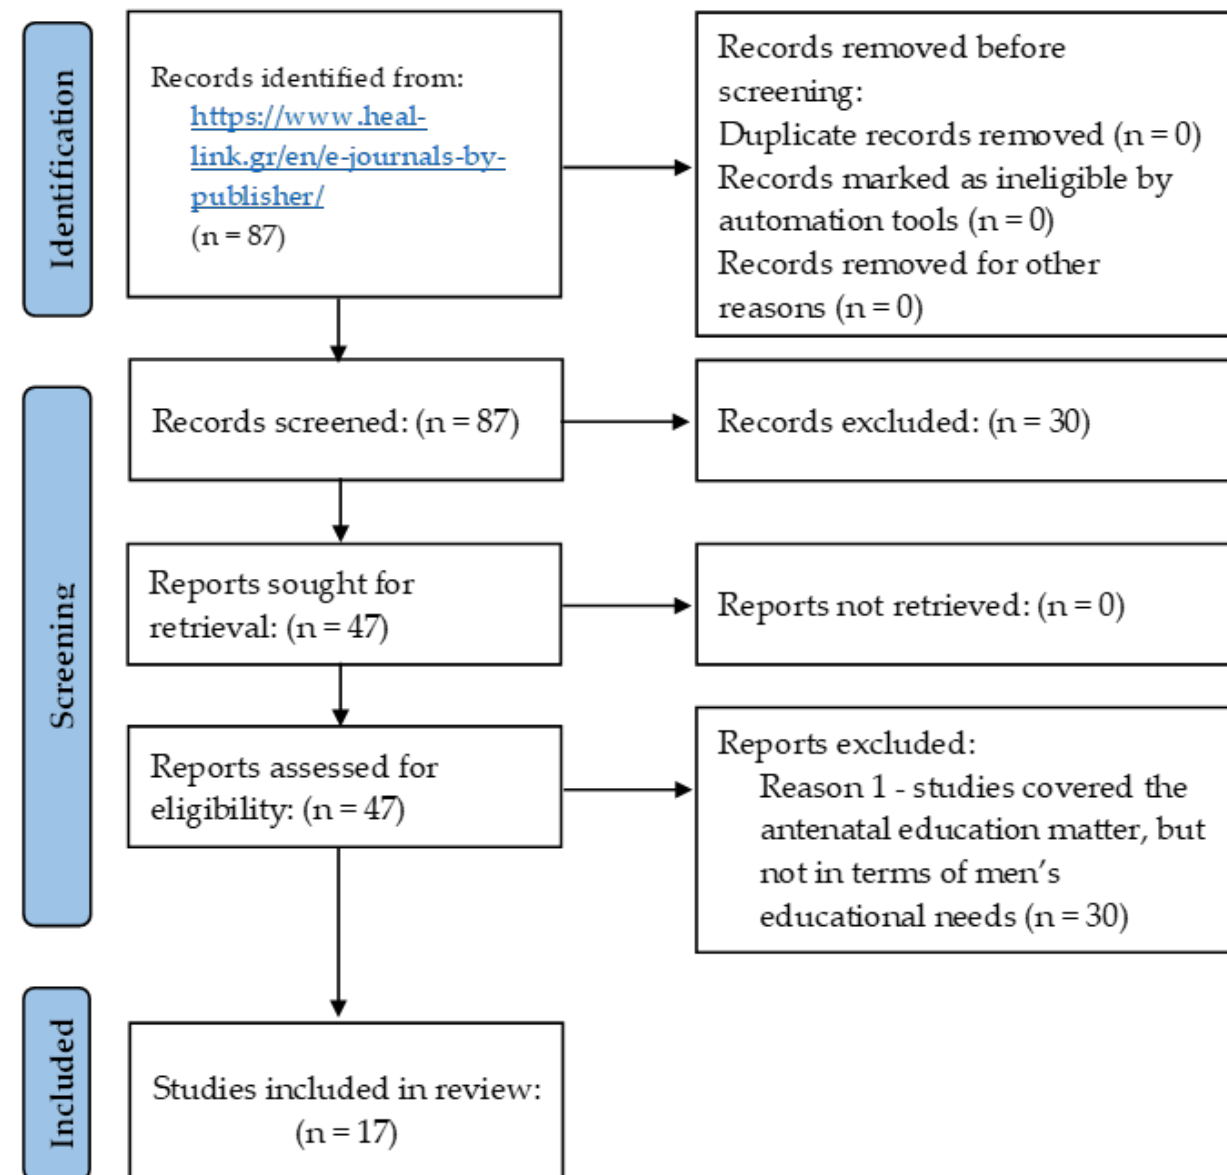
Figure 1. Flow diagram illustrating the article filtering process.